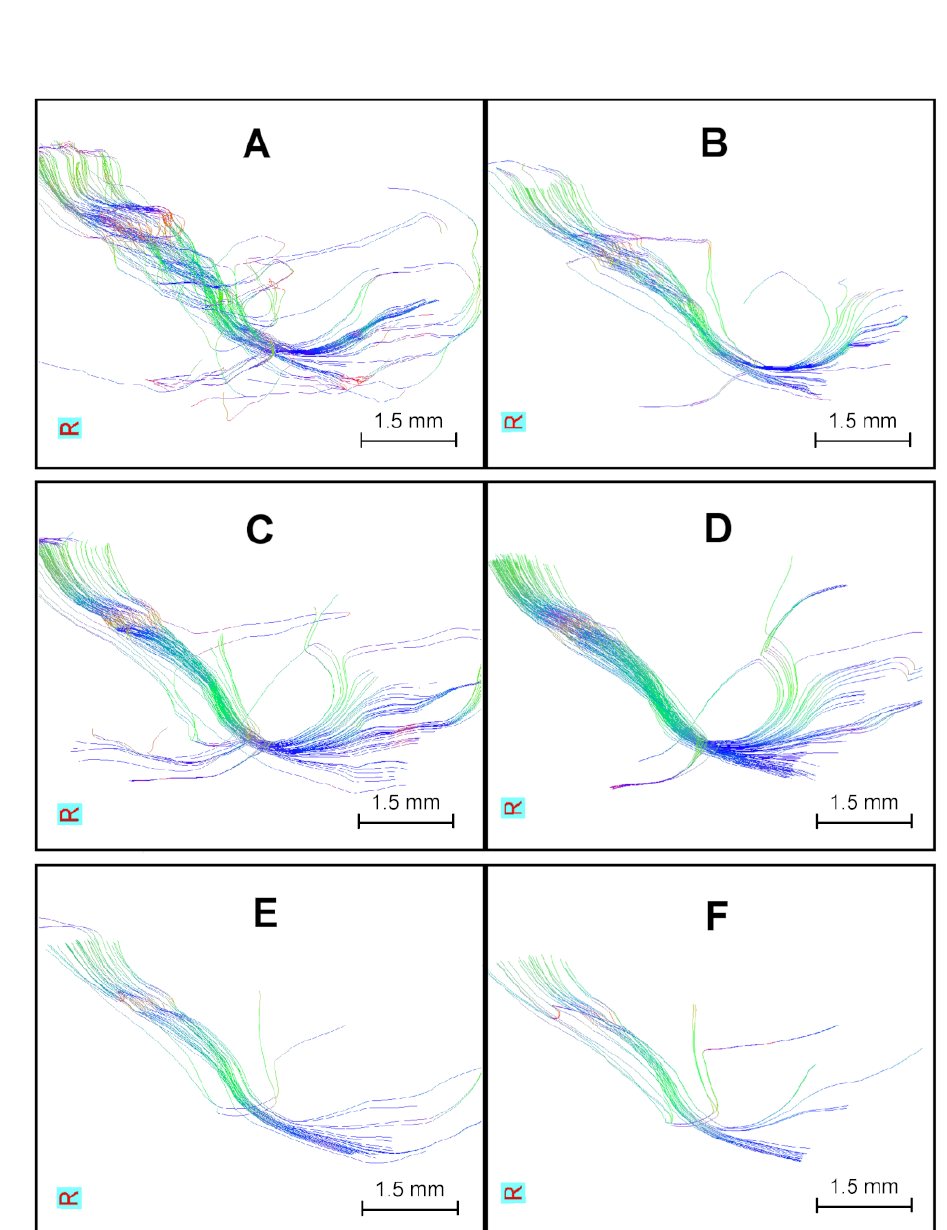
Figure 9: Sagittal views of the Corticospinal tract (CST) in different spatial resolutions. From top to bottom: tested resolutions ( 0 . 2 mm 3 , 0 . 3 mm 3 and 0 . 4 mm 3 ). Left column (A-E): CST in MoD. Right column (B-F): CST in averaged images. B is obtained from T-Avg_6 in Figure 9a. Replicating a likely execution framework in longitudinal studies. Pairs C-D and E-F corresponds to MoD bars and ∗∗ in Figure 8b and 8c respectively.